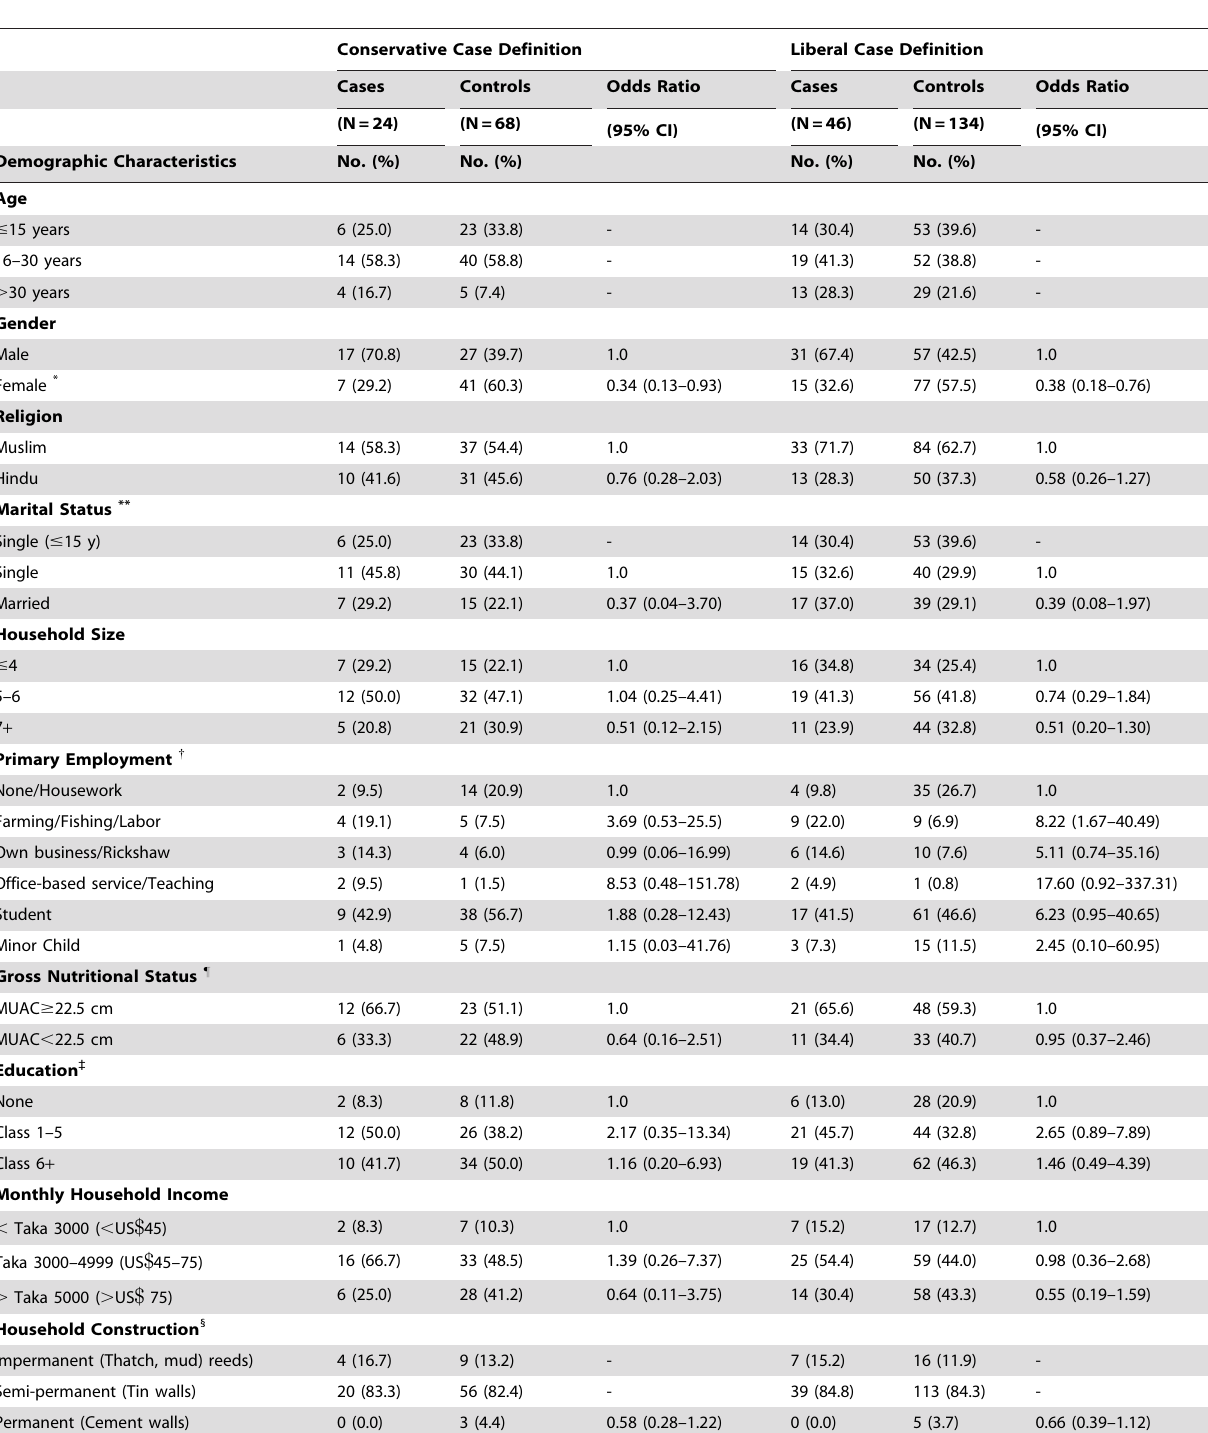
Table 3. Demographic characteristics of acute hepatitis E disease patients and age-matched